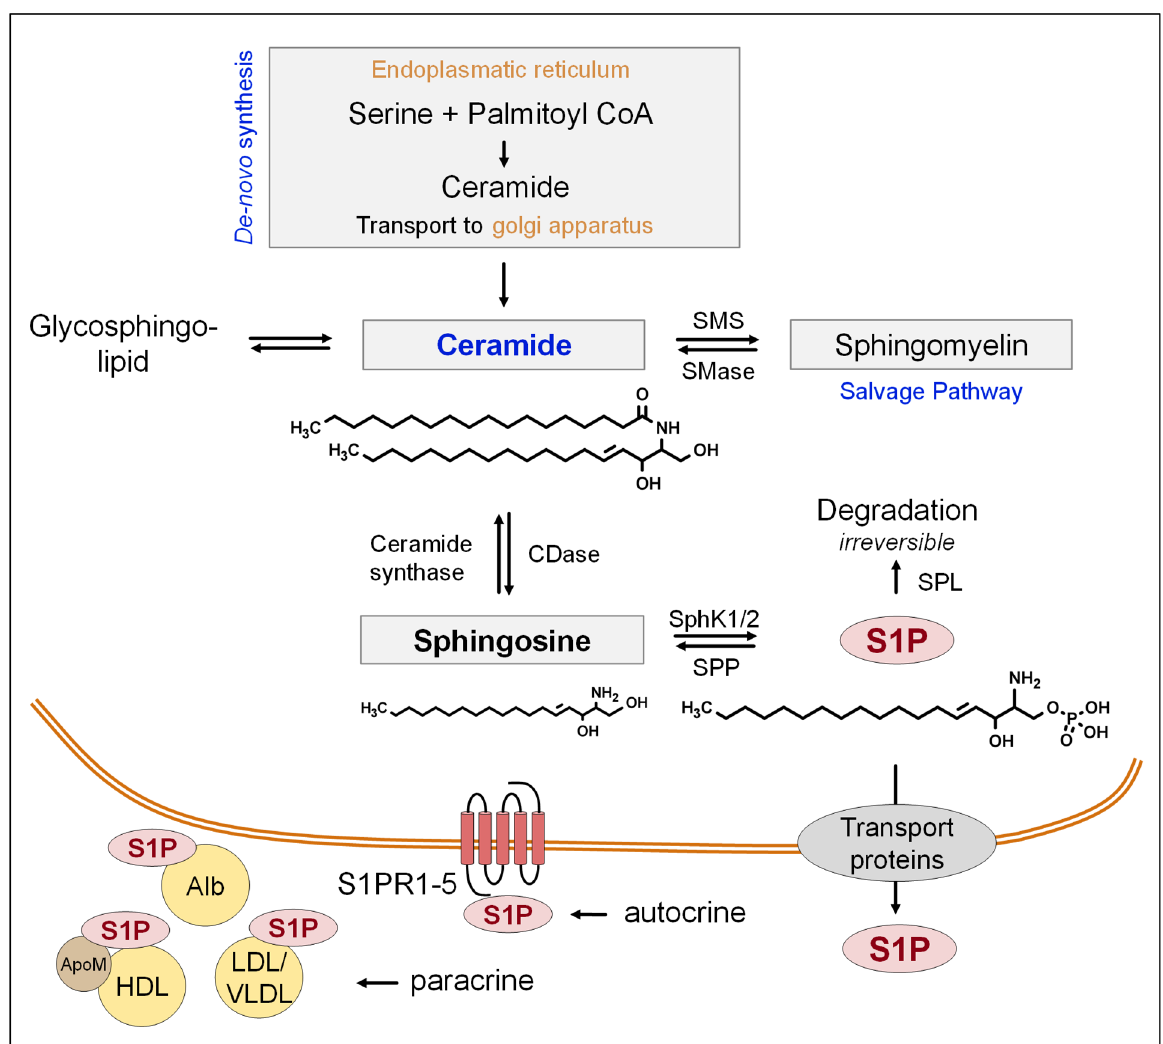
Figure 1. Metabolism of S1P, its cellular release, and binding partners. Sphingosine is formed via CDase from ceramides, which in turn can be formed de novo from serine and palmitoyl-CoA or sphingomyelin and glycosphingolipids. S1P is then formed intracellularly via SphK1/2 from sphingosine and transported out of the cell by ATP-binding cassette transporters (particularly ABCC4/MRP4) or the sphingolipid transporter 2 (Spns2) and the major facilitator superfamily transporter Mfsd2b. S1P can exert either paracrine or autocrine effects by binding to one of its G-protein-coupled receptors, S1PR1-5. Alb, albumin; apoM, apolipoprotein M; CDase, ceramidase; HDL, high-density lipoprotein; LDL, low-density lipoprotein; S1P, sphingosine-1-phosphate; SMase, sphingomyelinase; SMS, sphingomyelin synthase; SphK1/2, sphingosine kinase 1/2; SPL, S1P lyase; SPP, S1P phosphatase; S1PR1–5, S1P receptors 1–5; VLDL, very low-density